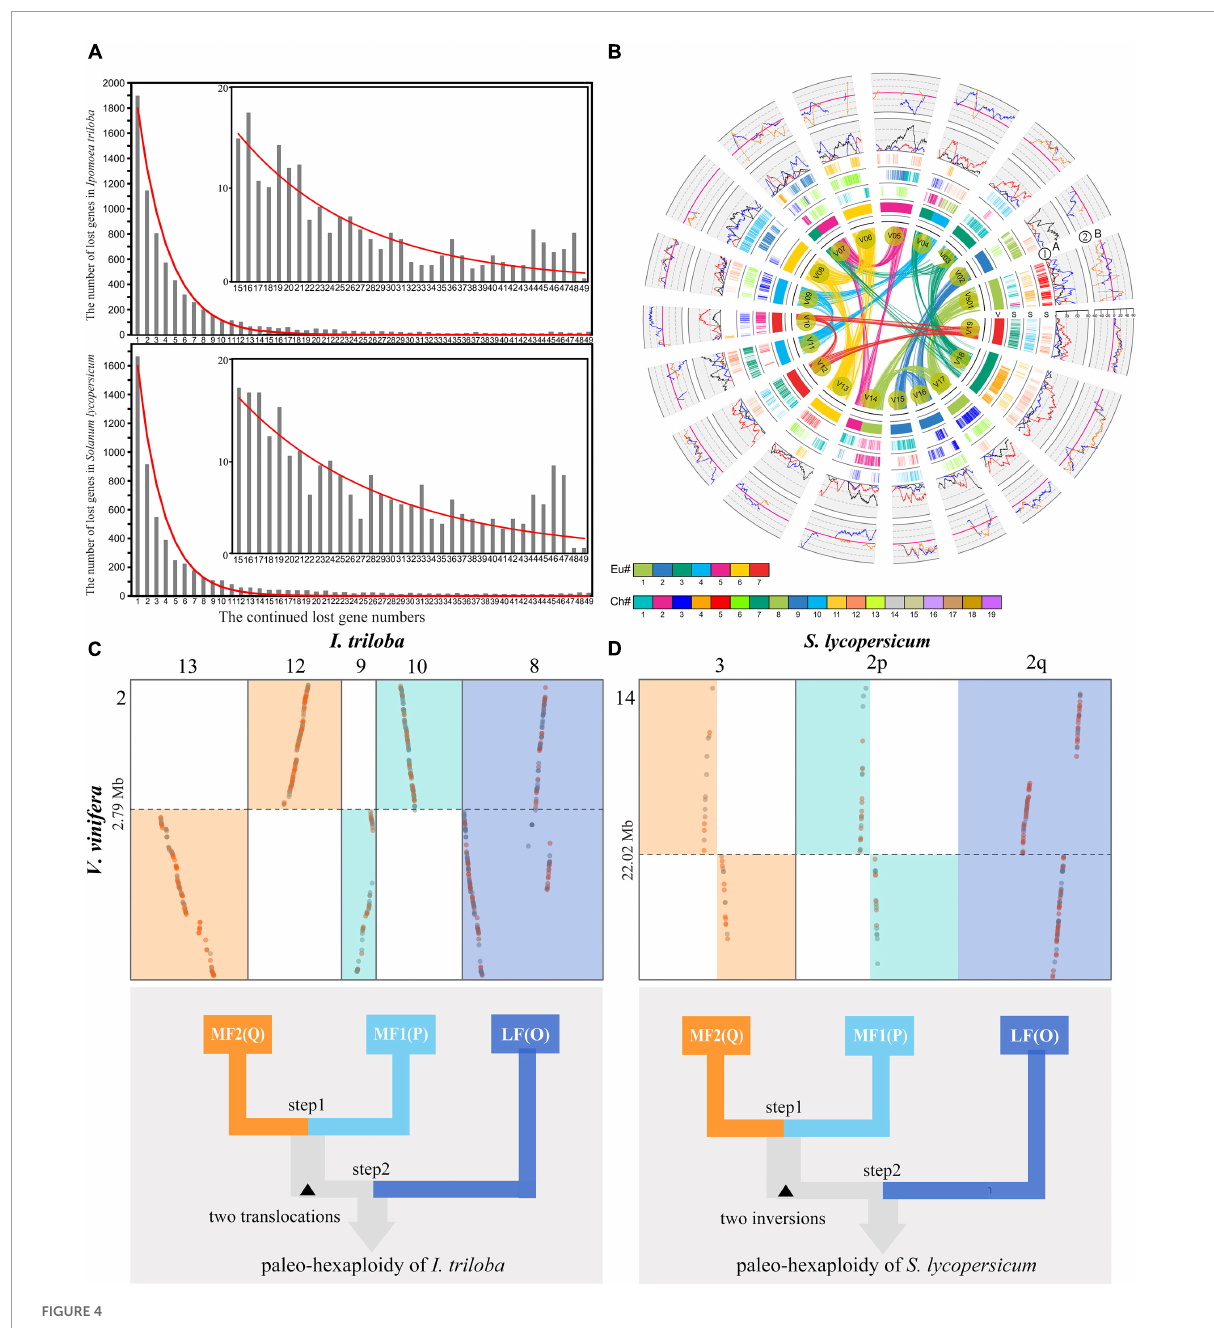
FIGURE4 Genomic fractionation and two-step duplications of the Solanaceae common hexaploidization (SCH) and Convolvulaceae common hexaploidization (CCH) events. (A) With Vitis vinifera as a reference, a geometric distribution was found for the gene loss pattern in Ipomoea triloba and Solanum lycopersicum . The x -axis shows the numbers of continuously missing genes in syntenic regions. The y -axis shows the frequency of identified continuously missing gene regions. The subfigure in the upper right shows the fitted geometric distribution of continuously missing genes, with a range of 15–49 genes. (B) Genomic alignments and gene retention of S. lycopersicum subgenomes along corresponding orthologous V. vinifera chromosomes. The genes in 19 chromosomes of V. vinifera within the inner circle colored by the seven ancestral chromosomes of core eudicots, as shown in the color scheme at the bottom (denoted by Eu#). Compared to the V. vinifera genome, the genomic paralogous and orthologous information within and among the genome of S. lycopersicum in subgenomes is displayed in three circles. Each circle is formed by short vertical lines that denote homologous orthologous genes, which are colored to indicate the 12 S. lycopersicum chromosome numbers in their respective source plant, as shown in the color scheme at the bottom (denoted by Chr#). (cid:192) Gene retention level of the least fractionated region (LF, red), the moderately fractionated region (MF1, blue), and the most fractionated region (MF2, grey) in S. lycopersicum . (cid:193) Difference in gene retention between LF and MF1 (pink) and between LF and MF2 (blue). (C) Local orthologous blocks identified between the V. vinifera and I. triloba genomes. Chromosome 2 in the V. vinifera genome was generated from one ancestral chromosome of core eudicots after ECH. One chromosome translocation was identified between MF1 and MF2. The bottom Figure